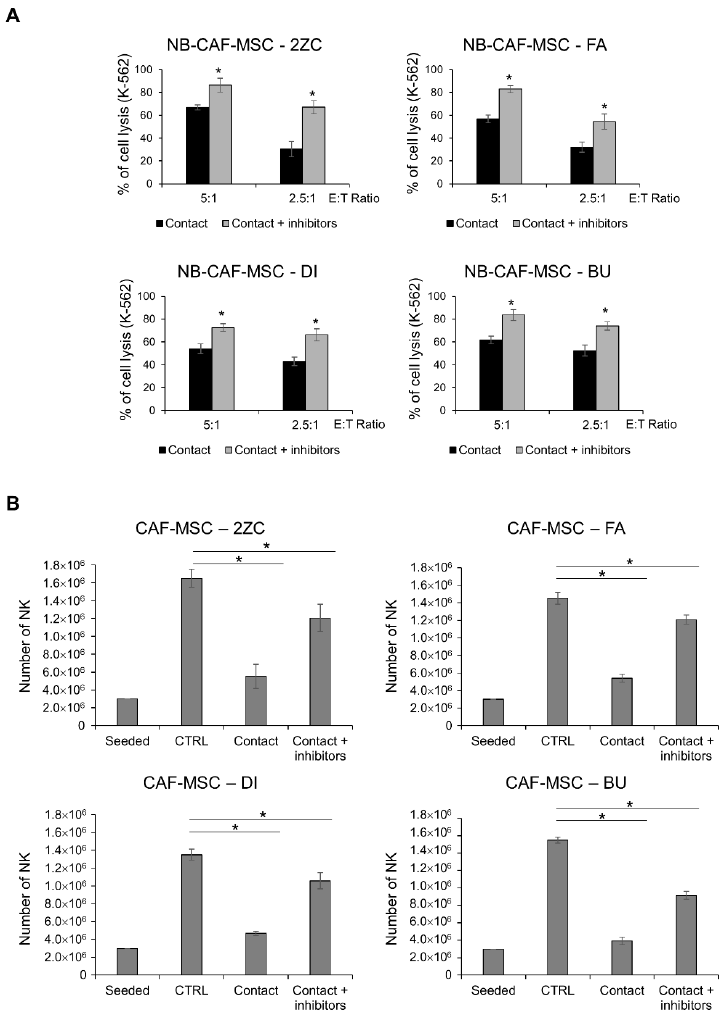
Figure 6. Effect of IDO and PGE2 inhibitors on NK cytotoxicity and proliferation under cell-cell contact conditions. ( A ) Percentage of K-562 cells lysis in cytotoxicity assays using freshly isolated NK cells after co-culture for 6 days with young/proliferating TA – MSC 2ZC, FA, DI and BU primary